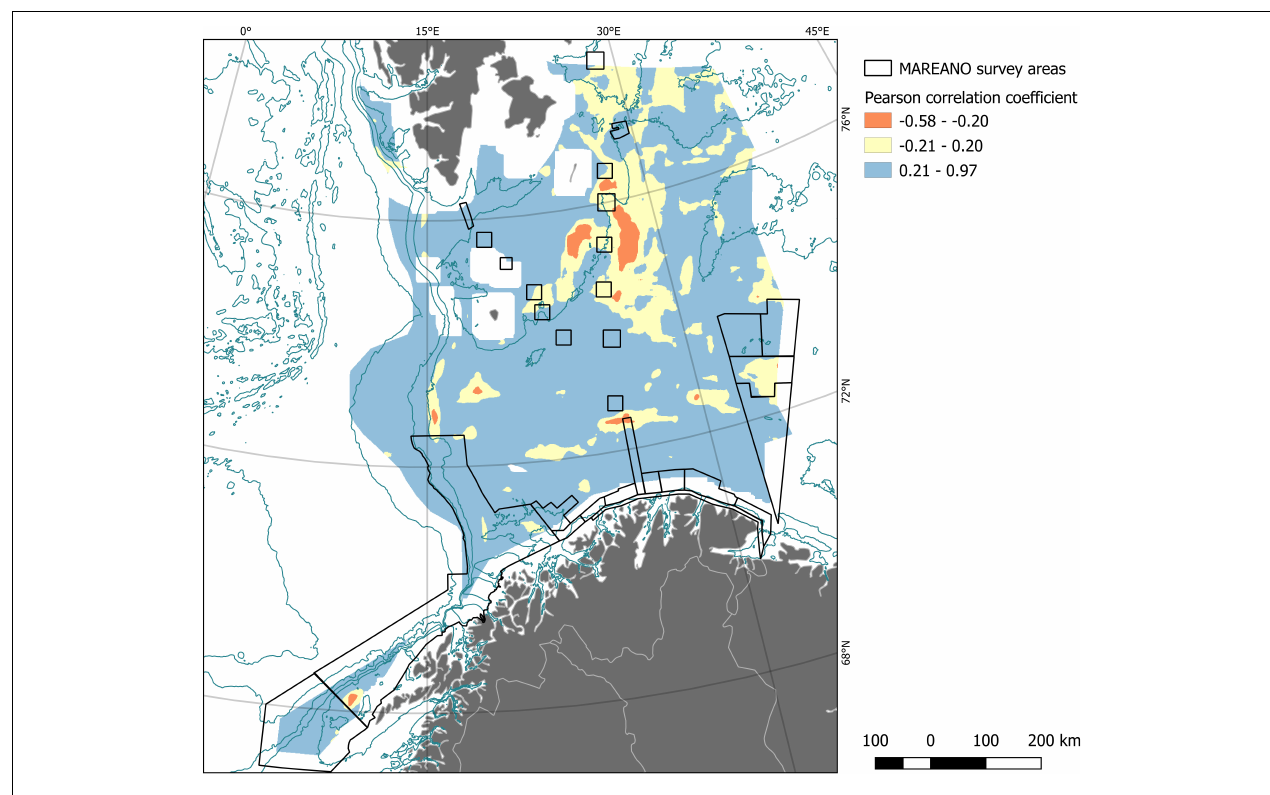
FIGURE 3 | Pearson correlation between predicted density and predicted probability of presence of soft-bottom, deep-sea sponges for each pixel was calculated within a running window of size 41 km by 41 km. In this figure we illustrate the areas where the correlation coefficient was most negative (red, see legend for coefficient values). In yellow are shown all areas where the correlation between the two models was around zero, meaning there was no correlation between the two models. Areas of model agreement are shown in blue. The black outline overlaid is the extent of the training data coverage. Also shown are selected bathymetric contour lines (dark blue) and land masses with political boundaries (gray), about which more details can be found in Figure 1